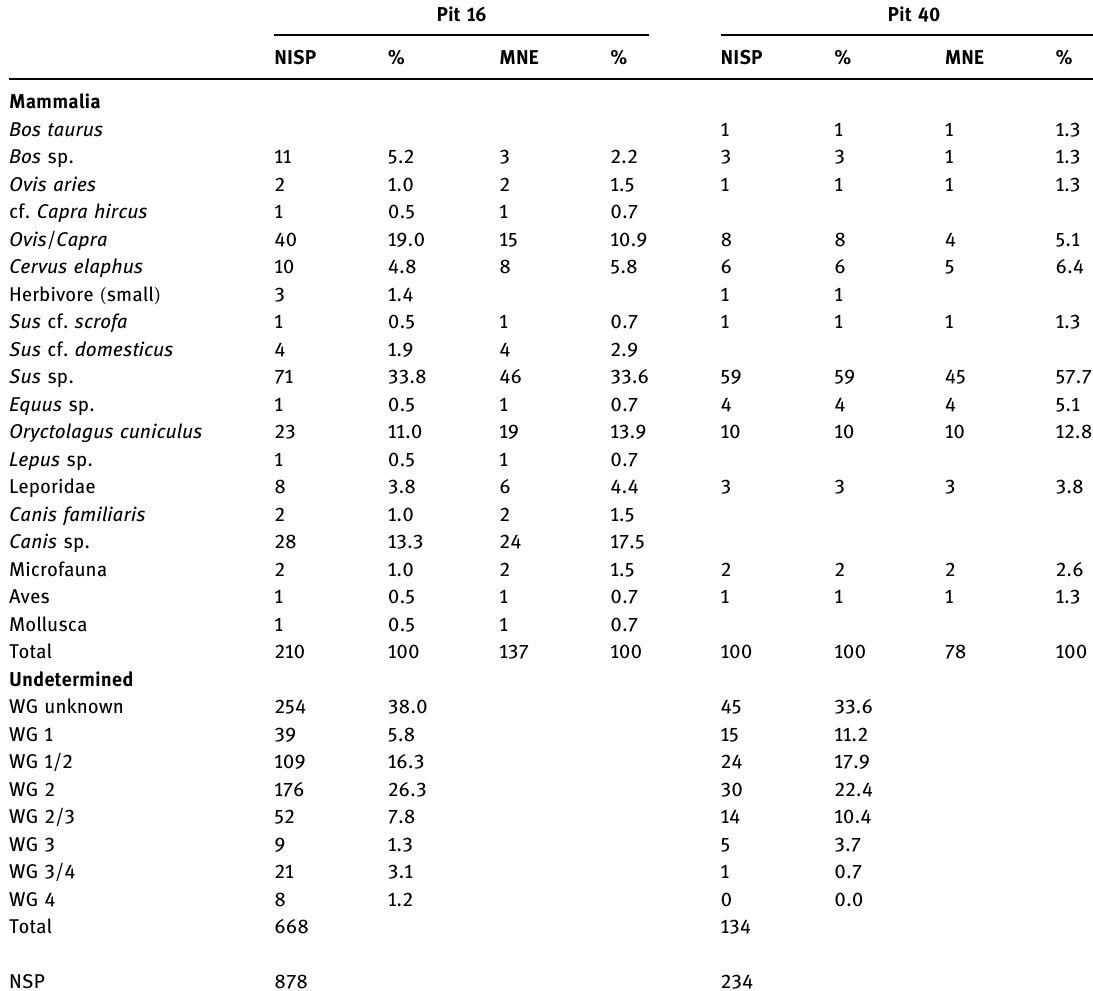
Table 1: Number of specimens ( NSP ) , number of identi fi ed specimens ( NISP ) and the minimum number of elements ( MNE ) calculated for pits 16 and 40, including undetermined remains identi fi ed to weight groups ( WG )